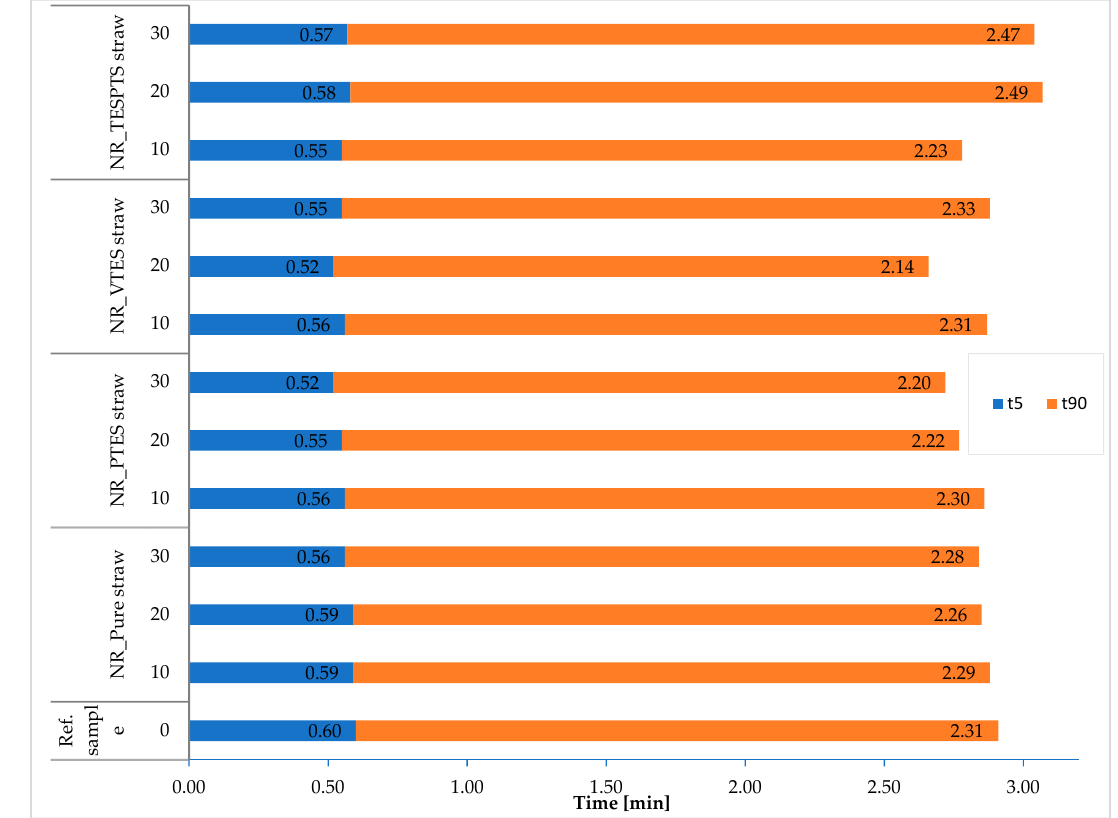
Figure 5. Curing characteristics of elastomer mixtures.